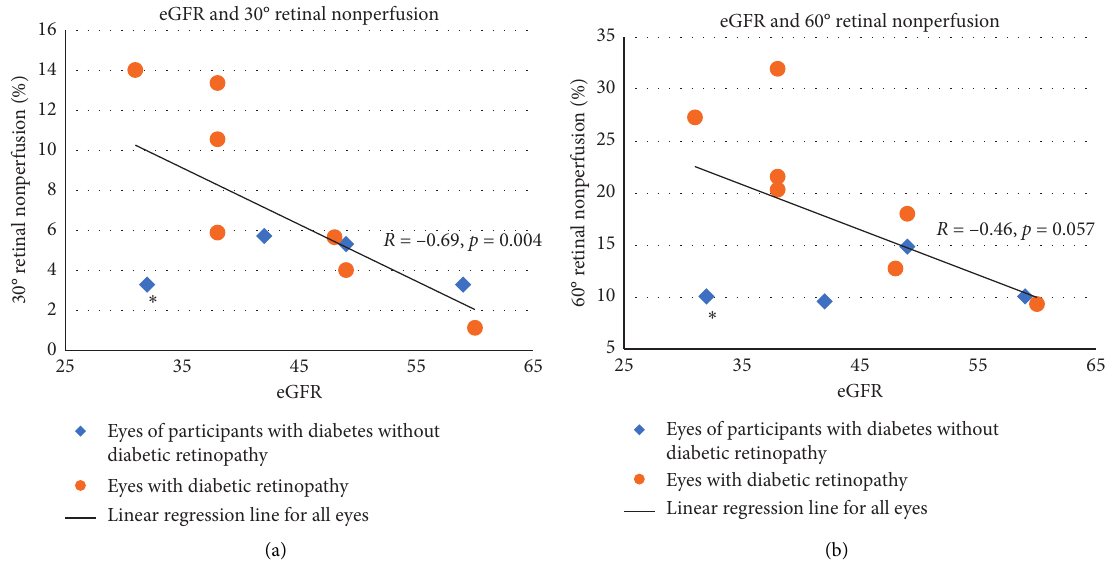
Figure 2: Estimated glomerular filtrate rate (eGFR) and retinal nonperfusion (RNP). Linear regression between eGFR and RNP. 30 ° field of view (FOV) (a) and 60 ° FOV (b) quantification results show a statistically significant negative correlation between eGFR and 30 ° retinal RNP in all participants. Diamonds represent eyes of patients with diabetes without diabetic retinopathy. Circles represent eyes with diabetic retinopathy. Solid black line shows the linear fit of all eyes. Asterisk ( ∗ ) highlights an outlier eye with low RNP and low